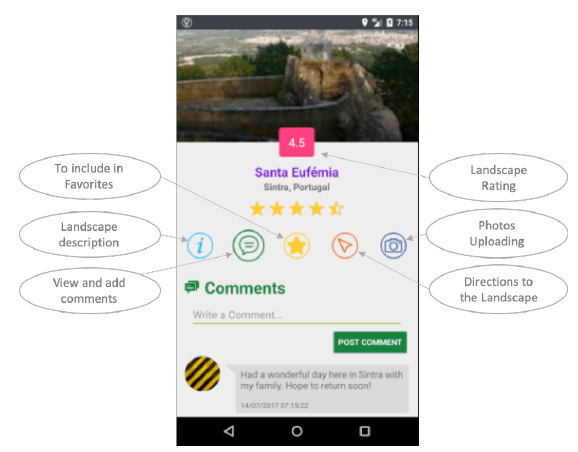
Figure 3. Landscape